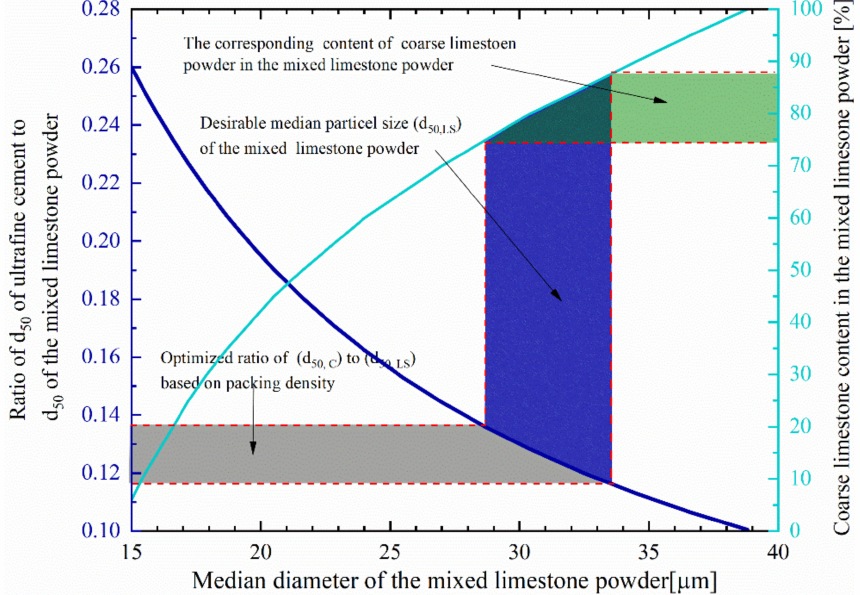
Figure 6. Relation between the size ratio, D 50 of the mixed limestone powder, and the needed content of coarse limestone